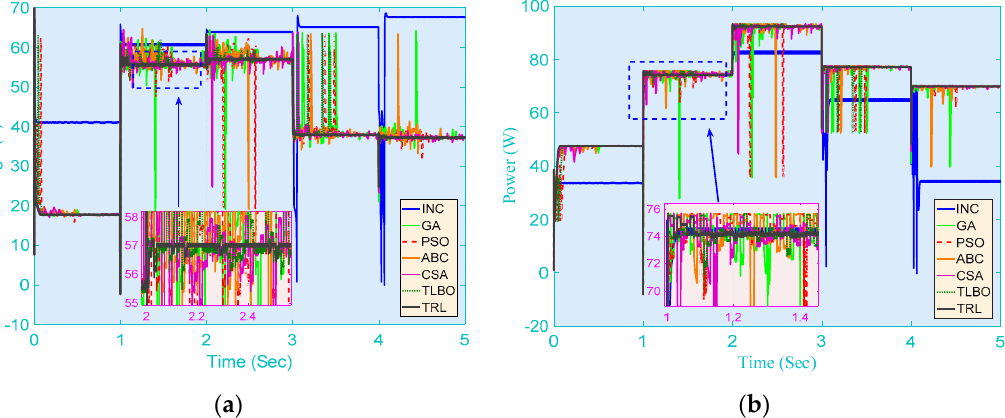
Figure 7. PV system responses of seven methods obtained on the step change in solar irradiation with constant temperature. ( a ) Voltage; ( b ) Power.